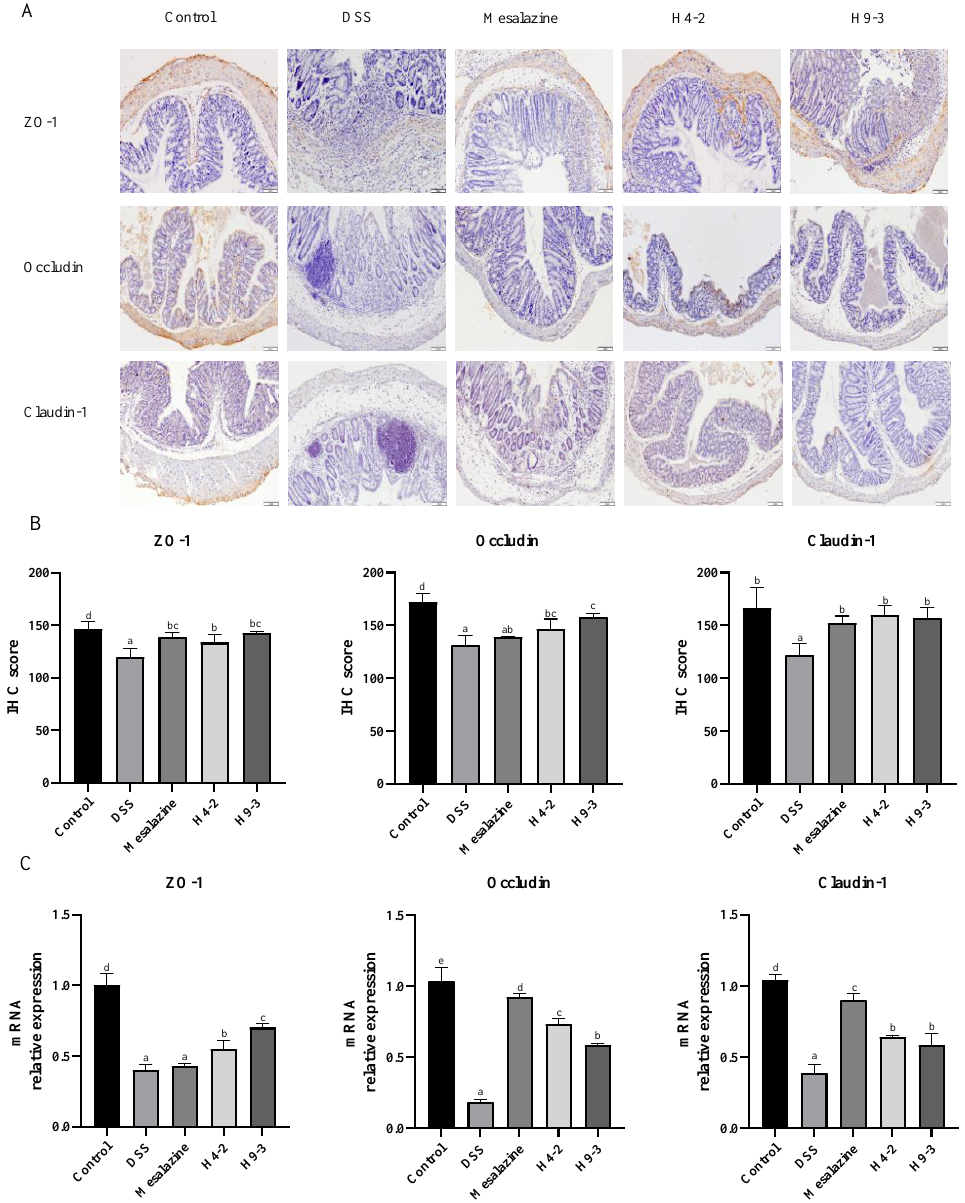
Figure 6. Effects of B. breve on the epithelial barrier. The IHC staining of TJ protein ( A ), IHC scores ( B ) and mRNA expression of TJ protein ( C ). Different lowercase letters (a, b, c, d) above the columns indicate significant differences ( p < 0.05), and the same superscript letters indicate that the differences between the values are not statistically significant ( p > 0.05).